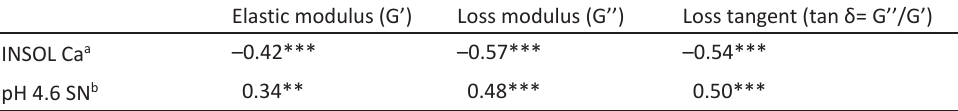
Table 4. Spearman correlation coefficients between viscoelastic and some compositional parameters during cheese ripening Elastic modulus (G’) Loss modulus (G’’) Loss tangent (tan δ=